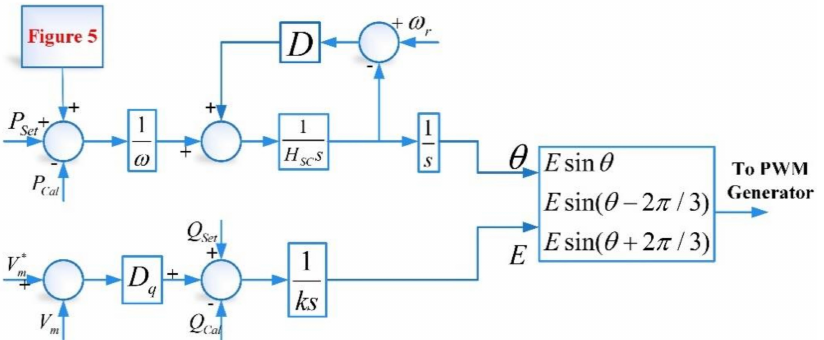
Figure 6. Proposed emulated inertia